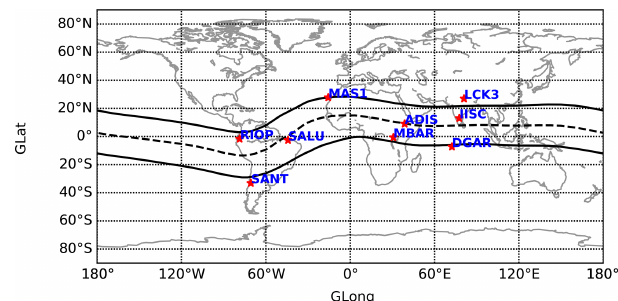
Figure 4. Map showing the location of IGS stations (red stars) con- sidered in this study. The black dotted line represents the magnetic equator, while at about ± 15 ◦ of magnetic latitude the black solid lines represent the EIA